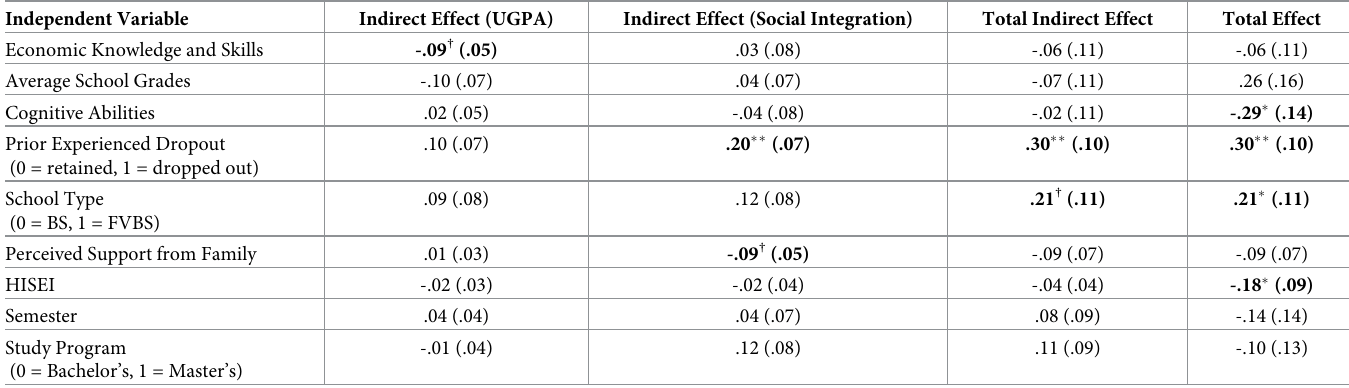
Table 10. Indirect and total effects on the intention to